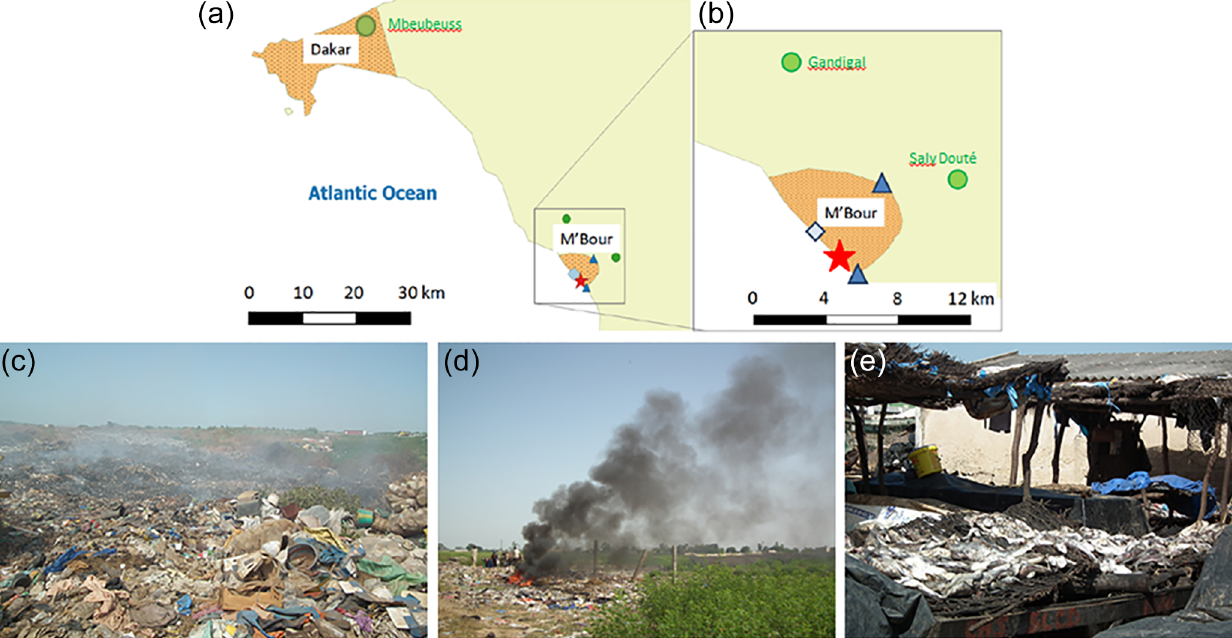
Figure 1. (a) Dakar and Mbour locations with city delimitations in orange and (b) local sources located around the IRD sampling site (red star), with open waste-burning areas (green circles), fish-smoking sites (blue triangles) and the Mbour port (light blue diamond). (c– e) Photographs of a smoldering fire in the Gandigal open waste-burning area, a flaming fire in the Saly Douté open waste-burning area, and a fish-smoking location (drying stage) in the suburb of